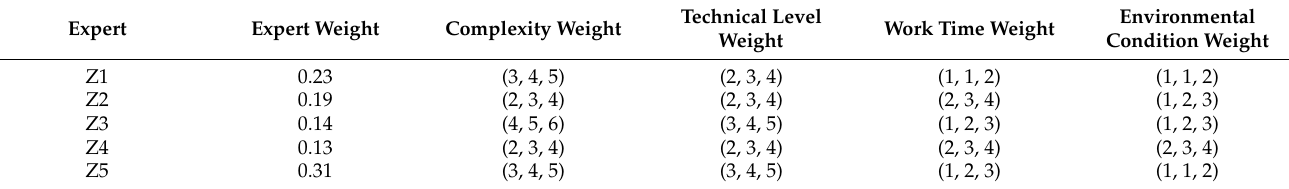
Table 4. Expert weight and evaluation factor weight